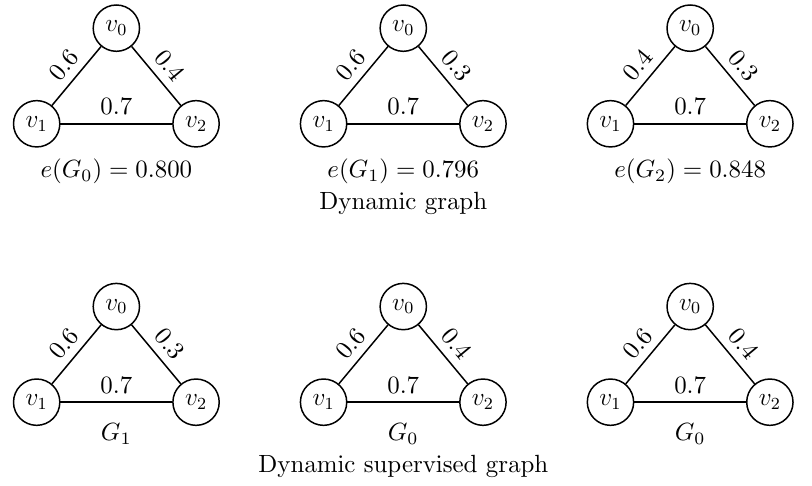
Figure 5. Example of the dynamic supervised graph.